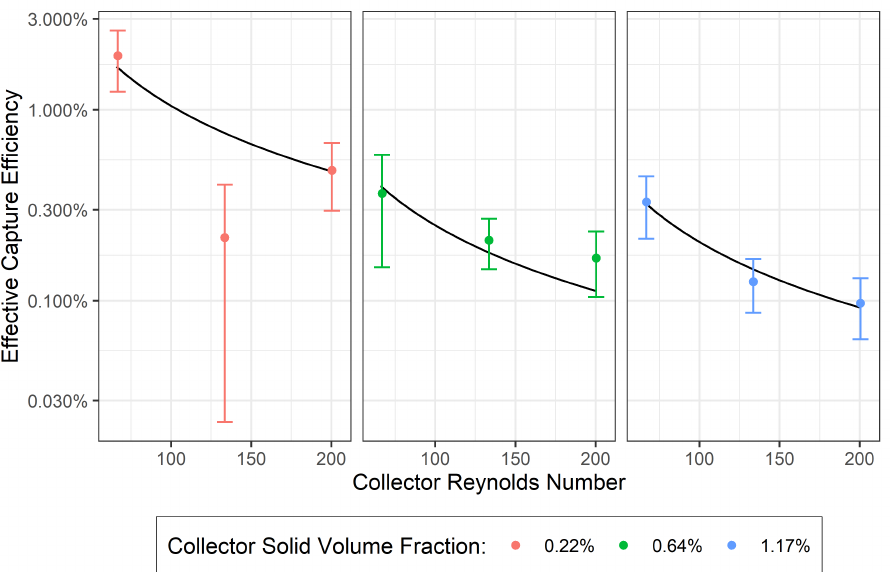
Figure 8. A comparison of our experimental estimates of effective capture efficiency, colored accord- ing to collector solid volume fraction ( φ c ), and the predictions of the Fauria et al. [10] power-law model (Equation (4); black lines), with uniquely calibrated C values for each φ c group. Effective capture efficiency is plotted on a logarithmic scale in order to display model fit more precisely at small values. Error bars represent ± 1